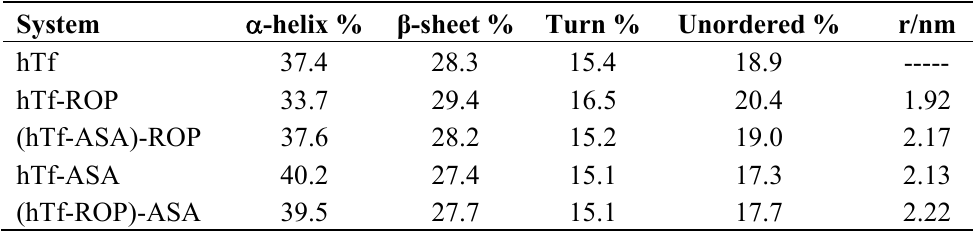
Table 3. Fractions of the secondary structure and binding distance (r) values of hTf with ROP and ASA complexes as binary and ternary systems, at pH = 7.4 and T = 298 K. System  -helix % β -sheet